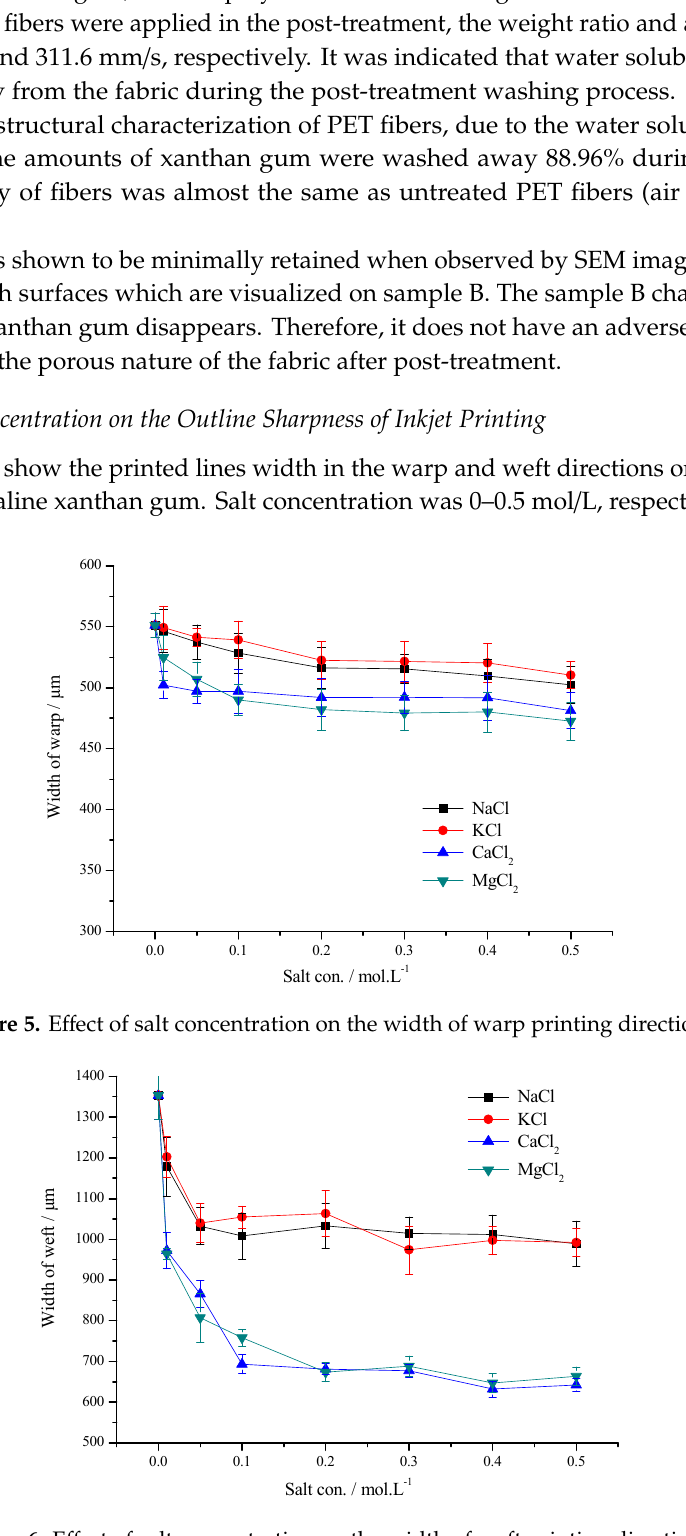
ff ect of salt concentration on the width of weft printing Figure 6. Effect of salt concentration on the width of weft printing direction. Figure 6. E